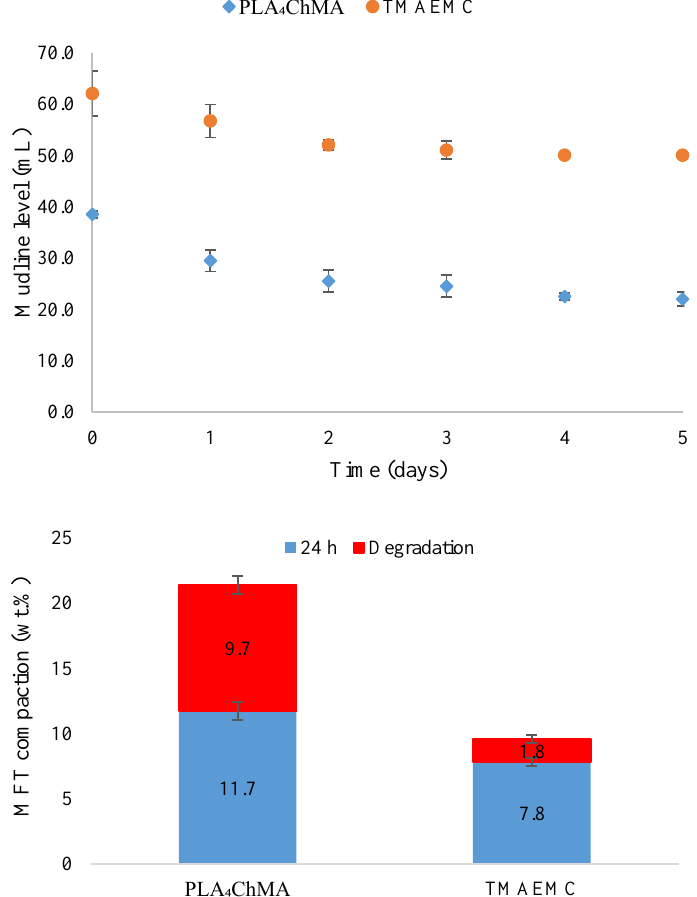
Figure 2. Comparison of continued settling during accelerated degradation after initial 24 h settling ( top ) and compactions before and after degradation ( bottom ) of 5.0 wt.% mature fine tailings (MFT) from flocculation in deionized water using 10,000 ppm of poly(PLA 4 ChMA) and poly(TMAEMC) (trimethylaminoethyl methacrylate chloride).